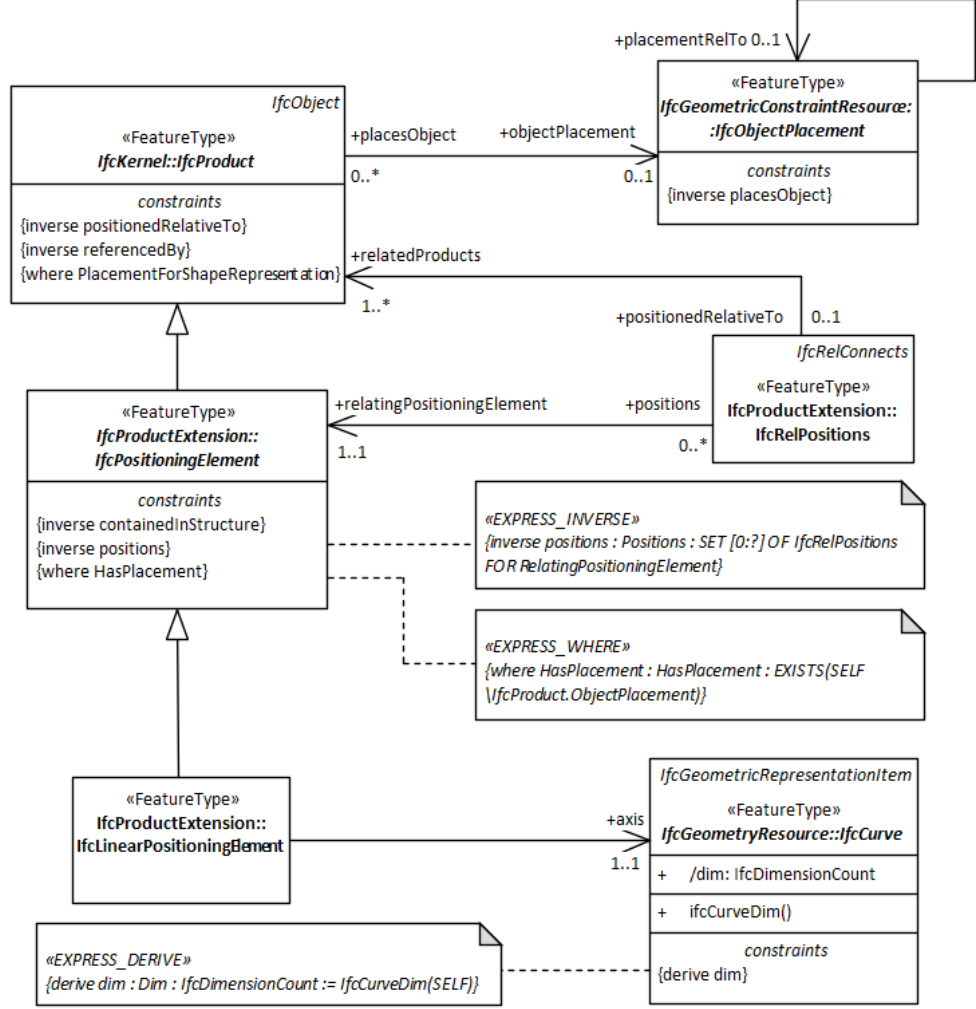
Figure 9. UML class diagram showing examples of IFC constraints converted to UML.